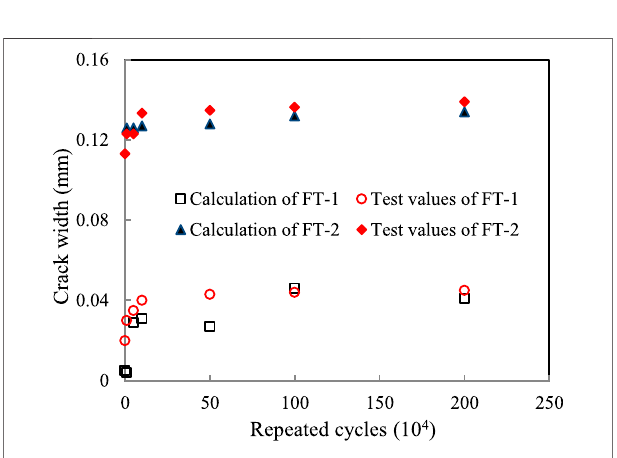
FIGURE 10 | Veri fi cation of the calculation model with a fatigue test conducted by Lin et al. (2013).